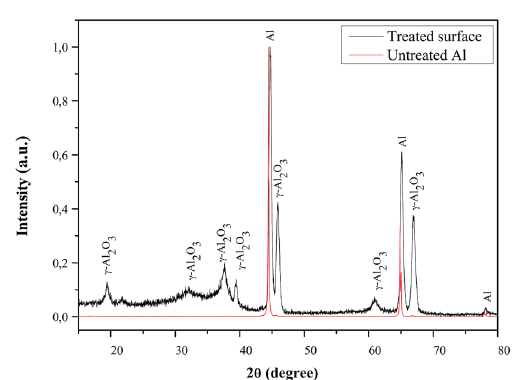
Figure 3. X-ray diffraction, grazing incidence, of the surface sample after electrolytic plasma treatment, and the untreated Al